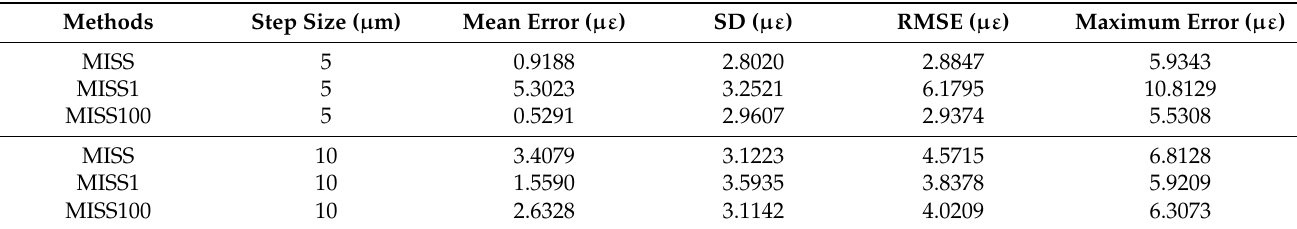
Table 1. Error analysis for the static tests.